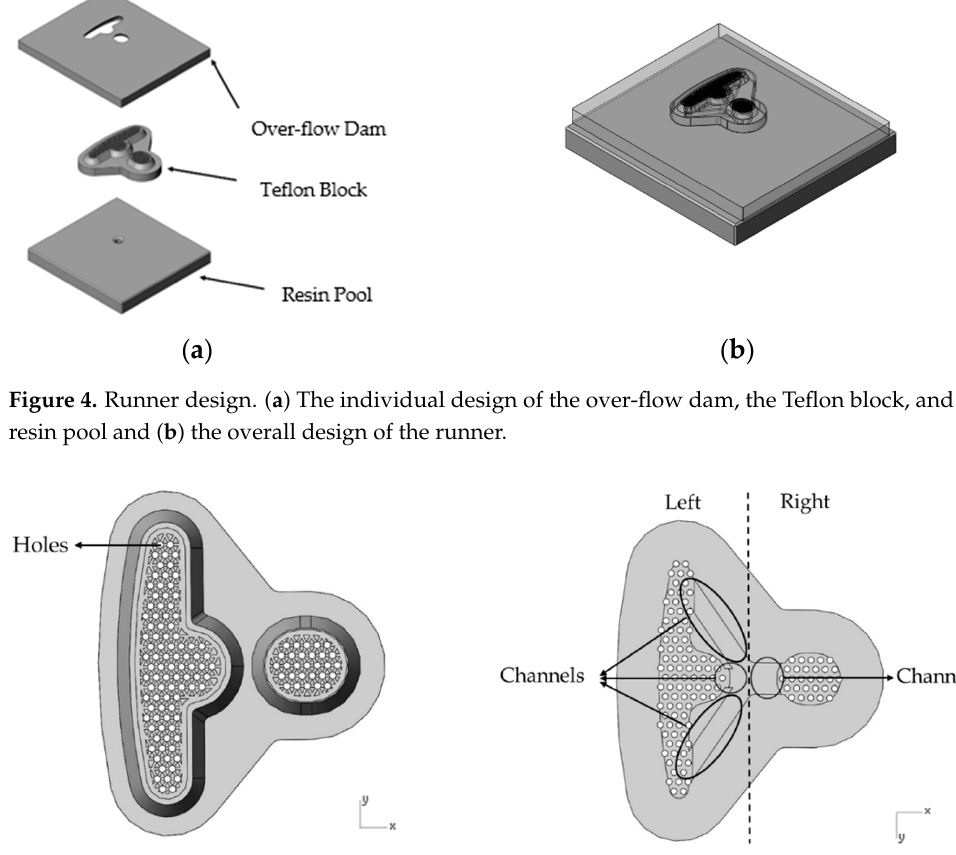
Figure 6. The design of the fine mesh nets. ( a ) Illustration of partial enlargement of fine mesh and ( b ) top view of the design of the fine mesh nets. Figure 7a,b show the simulation flow chart, which includes the mold flow analysis and dipping analysis, where it can be seen that the results of the mold flow analysis were used as the initial conditions for the dipping analysis. In this experiment, there were two different designs of the structures to find out their resin distributions. Figure 8a,b show one design consisted of four parts: the fine mesh nets on the Teflon block, a Teflon block, the over-flow dam, and the resin pool. This design was defined as Case 1. Figure 9a,b show the other design consisted of five parts: the fine mesh nets on the Teflon block, the fine mesh nets between the Teflon block, a Teflon block, the over-flow dam, and the resin pool. This design was defined as Case 2. The purpose of this experiment was basically to